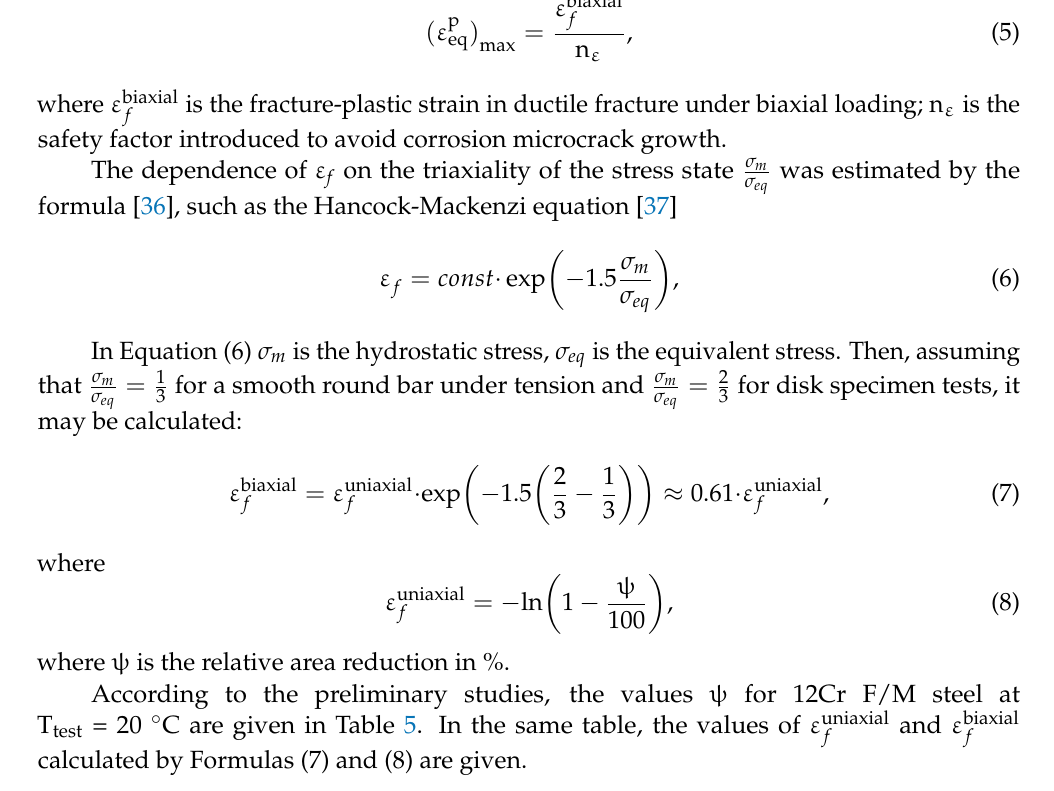
Table 5. The values ψ , ε uniaxial